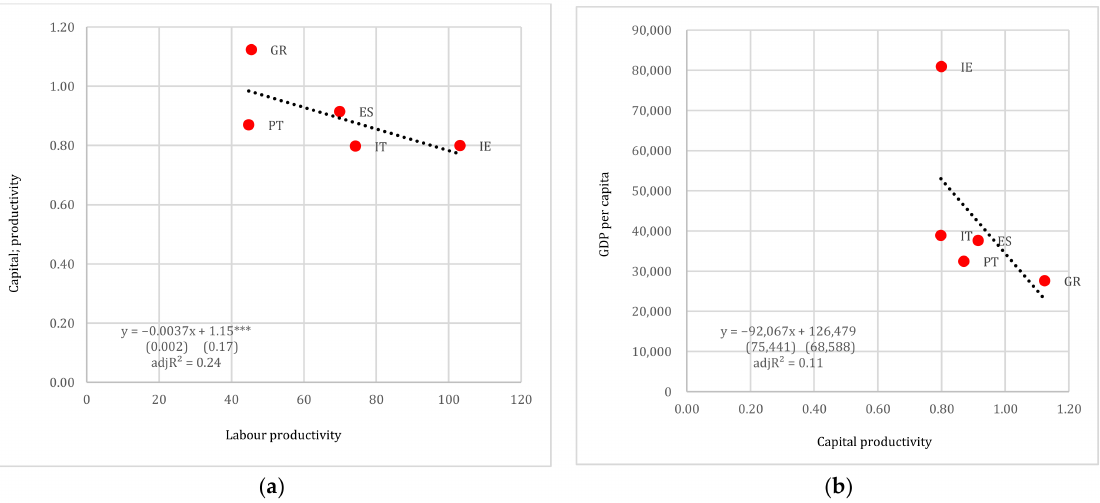
Figure 11. ( a ) Labour productivity vs. capital productivity and ( b ) capital productivity vs. GDP per capita (in USD pps), PIIGS. Note: Standard errors reported in parentheses. *** denotes 1% levels of statistical significance.